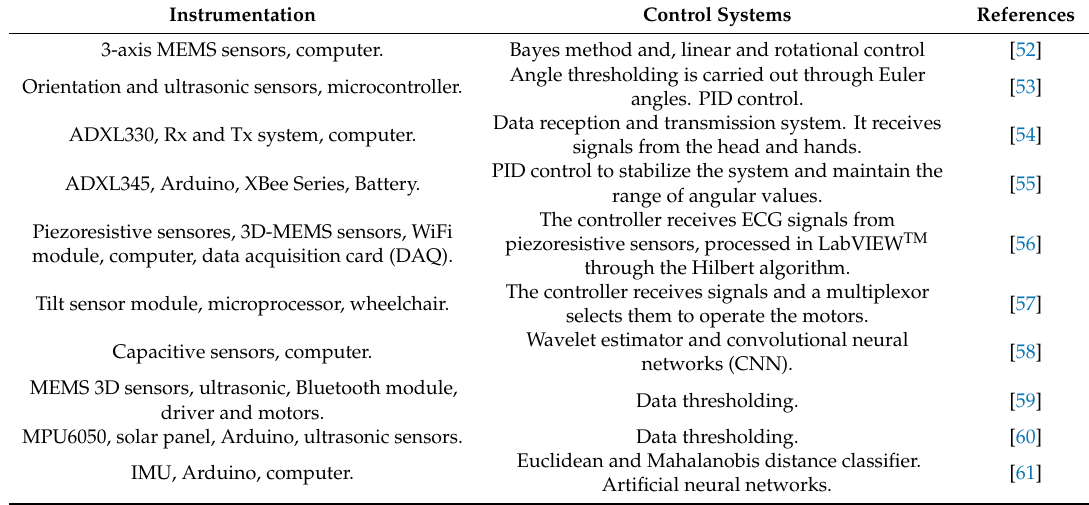
Table 5. Instrumentation and control strategies for MEMS